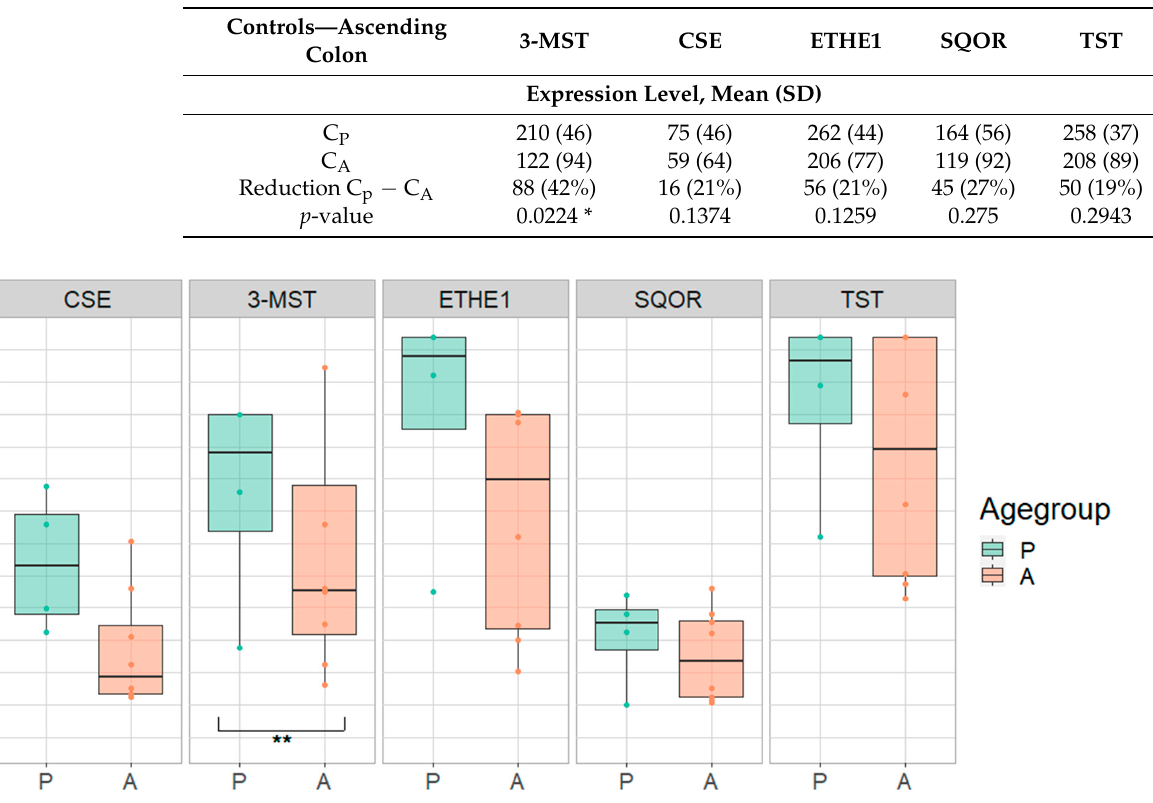
Figure 3. Expression of cystathionine- γ -lyase (CSE), 3-mercapto-sulfurtransferase (3-MST), ethyl- malonic encephalopathy 1 protein (ETHE1), sulfide:quinone oxidoreductase (SQOR) and thiosulfate sulfurtransferase (TST) in pediatric (P) and adult (A) samples in the terminal ileum of pediatric (P) and adult (A) healthy controls. Range of expression levels from a minimum of 0 to a maximum of 300. ** = p -value <